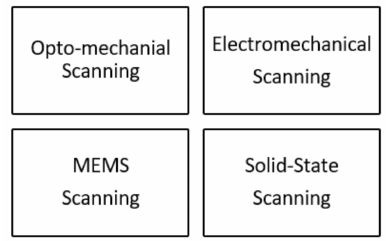
Figure 4. Classification of scanning mechanism for LiDAR systems.